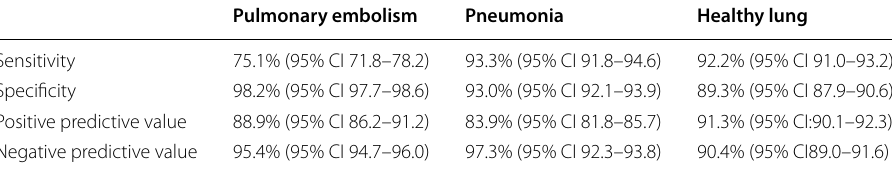
Table 6 Sensitivity, specificity, PPV and NPV statistics for the test set of